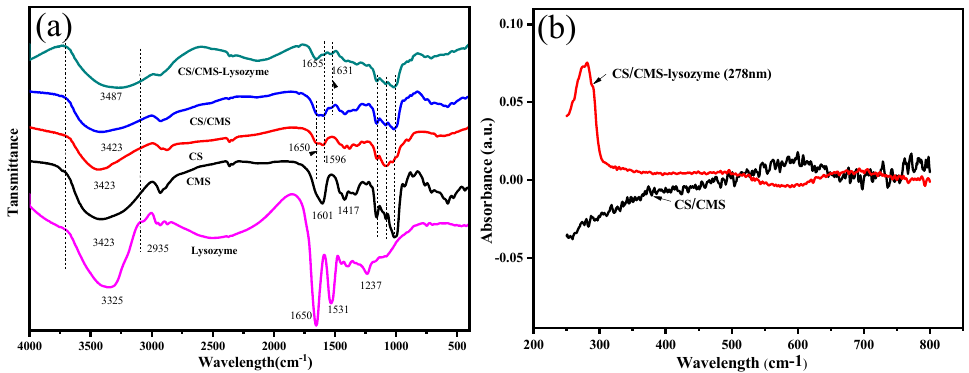
Figure 4. ( a ) FTIR spectra of lysozyme, CS, CMS and CS/CMS-lysozyme microspheres, ( b ) UV-visible absorption spectra of CS/CMS-lysozyme and hollow CS/CMS microspheres.